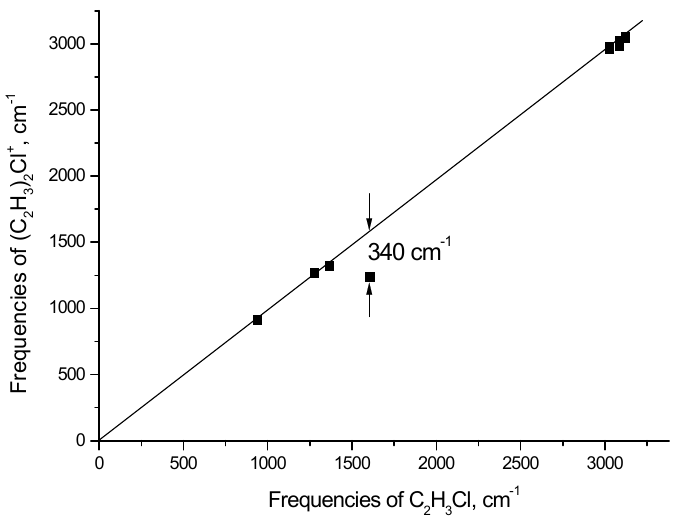
Figure 13. Correlation between the empirical frequencies of the C 2 H 3 group of the C 2 H 3 Cl molecule and those of the (C 2 H 3 ) 2 Cl + cation.